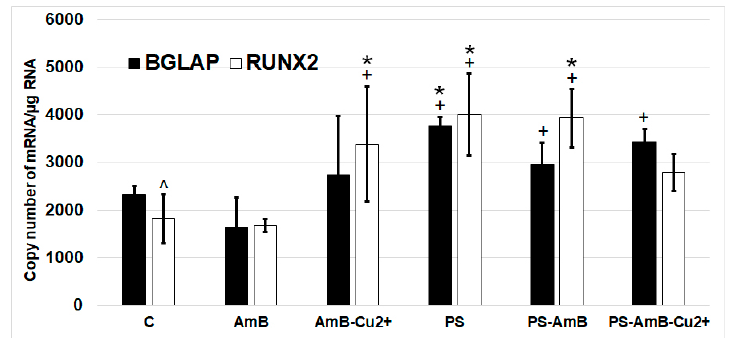
Figure 8. The mRNA levels of osteoblastic markers BGLAP and RUNX2 in the ADSC after exposure to the tested antibiotic combinations. The bars represent the means ± standard deviation (SD) of the copy numbers per 1 µg of total RNA; ANOVA with the Tukey post hoc test, * p < 0.05 vs. control, + p < 0.05 vs. AmB, ^ p < 0.05 vs. AmB-Cu 2+ .